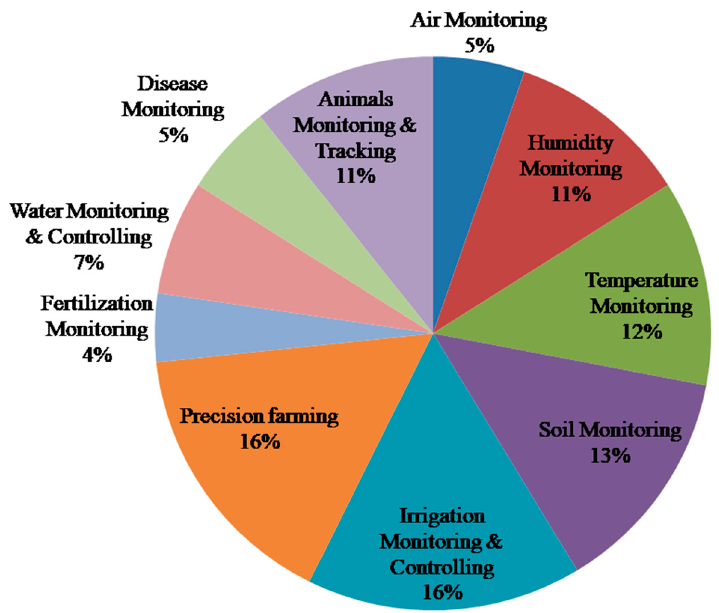
Figure 5. IoT agriculture applications.